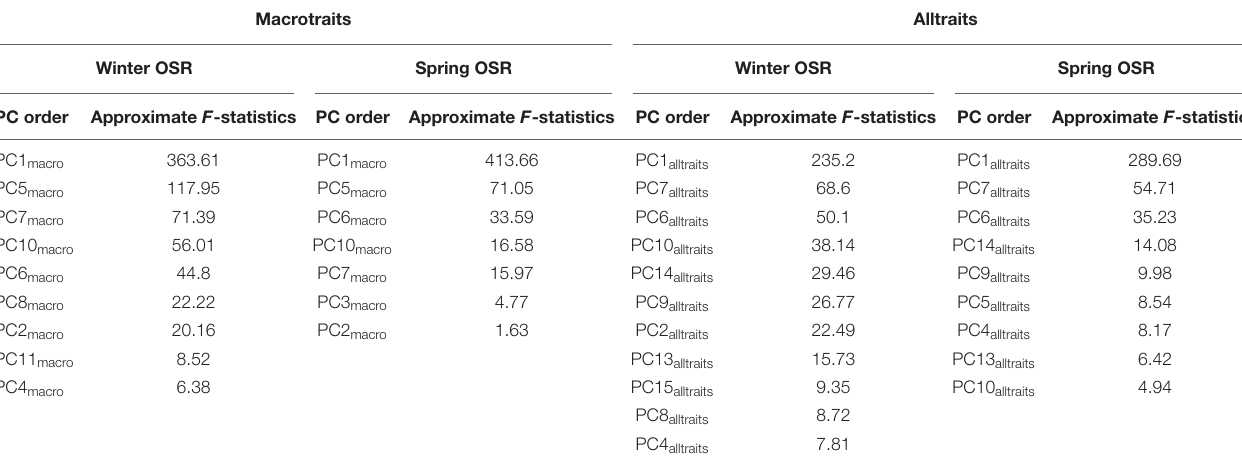
TABLE 4 | Reproductive strategies (PCs) that significantly contribute to seed yield in Winter OSR and Spring OSR for macrotraits and for alltraits (macro and microtraits together) when dropping terms. Macrotraits